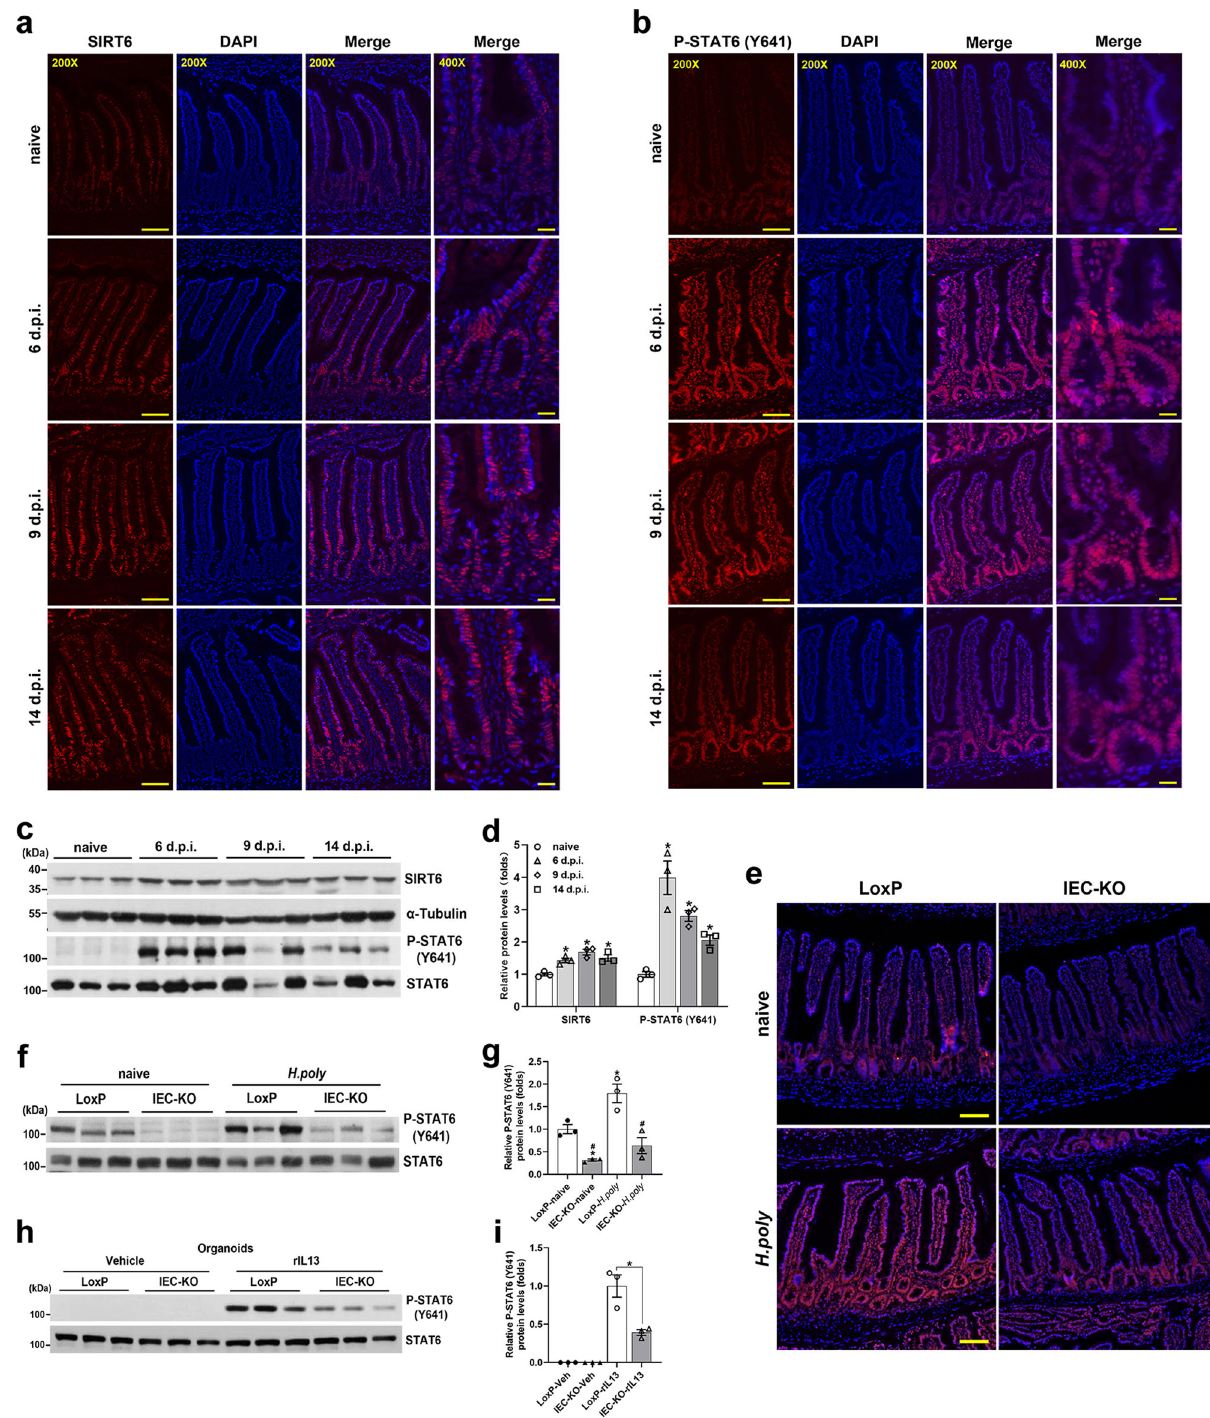
Fig. 4 | IEC ablation of Sirt6 attenuates the Tyr641 phosphorylation of STAT6. a – d 2-month-old C57BL/6J male mice were infected with H. poly and analyzed on indicated days post-infection. a , b Immunostaining for SIRT6 ( a ) and P-STAT6 (Y641) ( b ) in the jejunum. c , d Western blot ( c ) and quanti fi cation ( d ) analyses of SIRT6 and P-STAT6 (Y641) in the jejunal IECs. n =3 mice/group; p =0.0102 (6 dpi), 0.006(9dpi),0.0203(14dpi)forSIRT6; p =0.0259(6dpi),0.0025(9dpi),0.0089 (14 dpi) for P-STAT6. e – g 2 – 3-month-old male naive and H. poly -infected LoxP and IEC-KO mice were subjected to the following assays on day 14 post-infection.